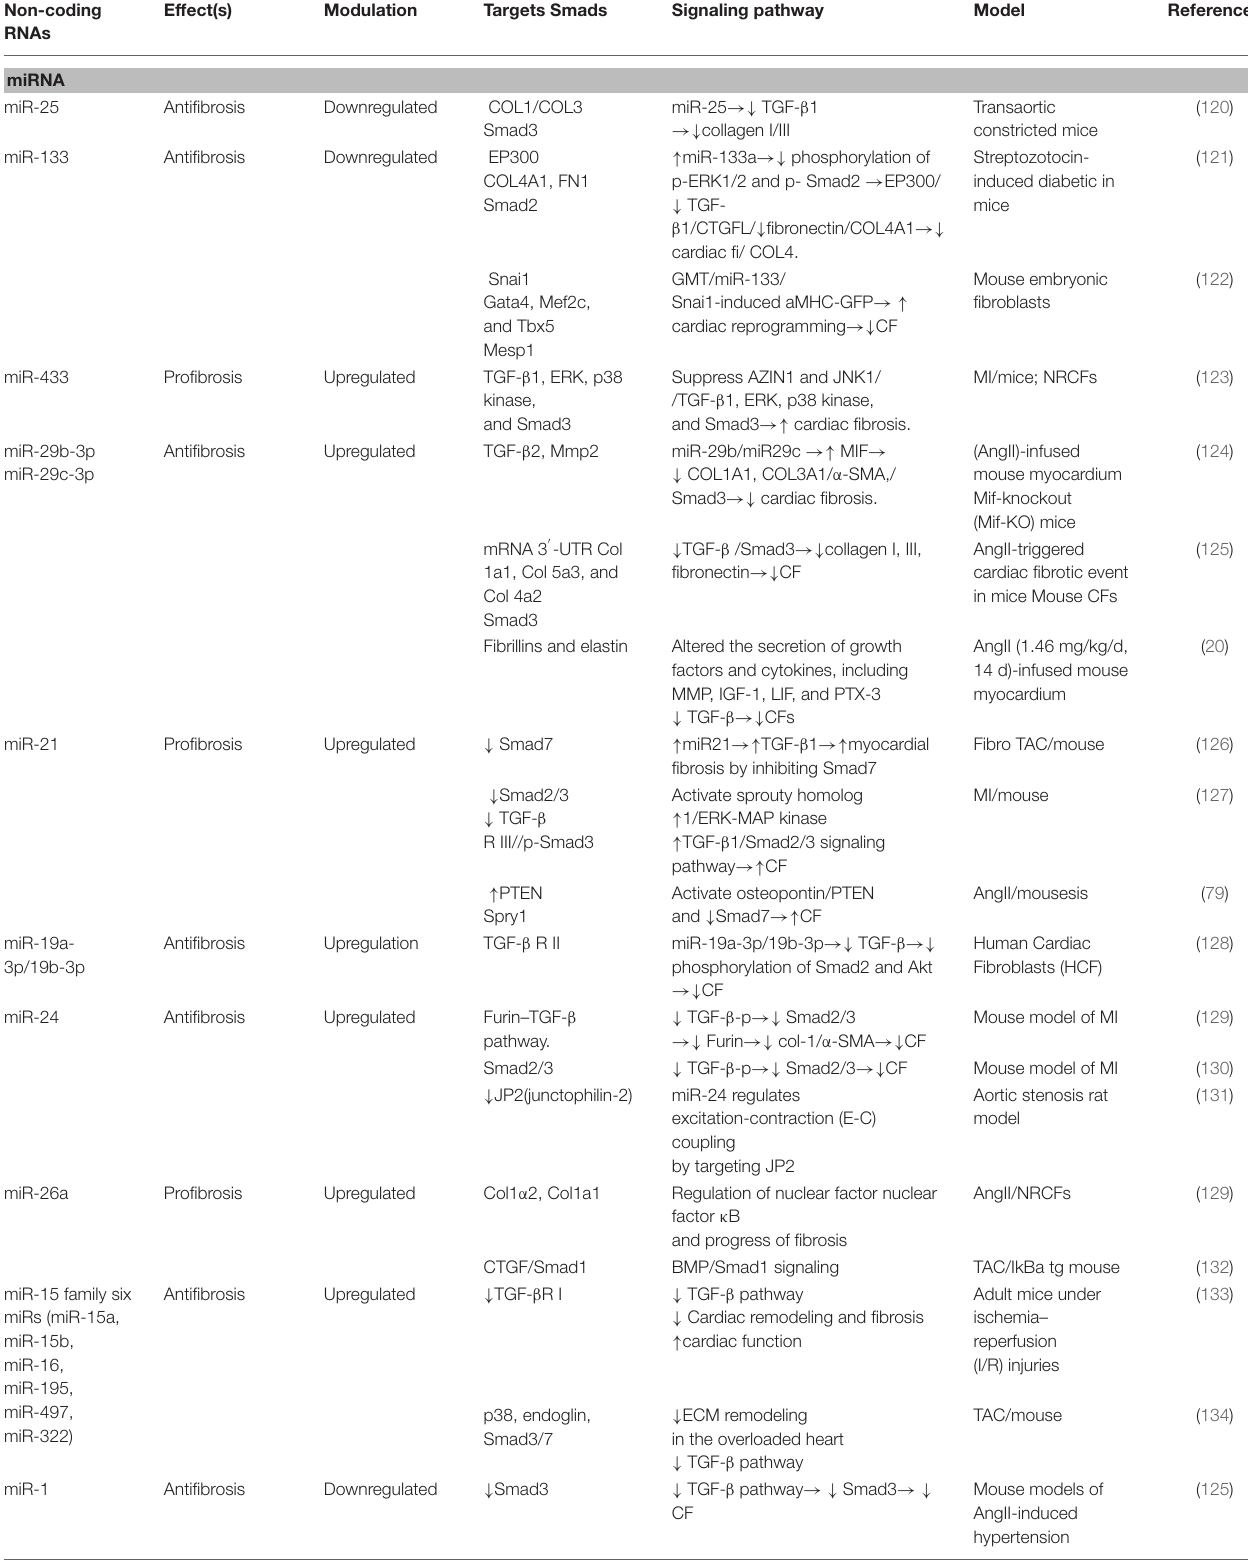
TABLE 2 | ncRNAs and TGF- β /Smad signaling in cardiac fibrosis. Non-coding